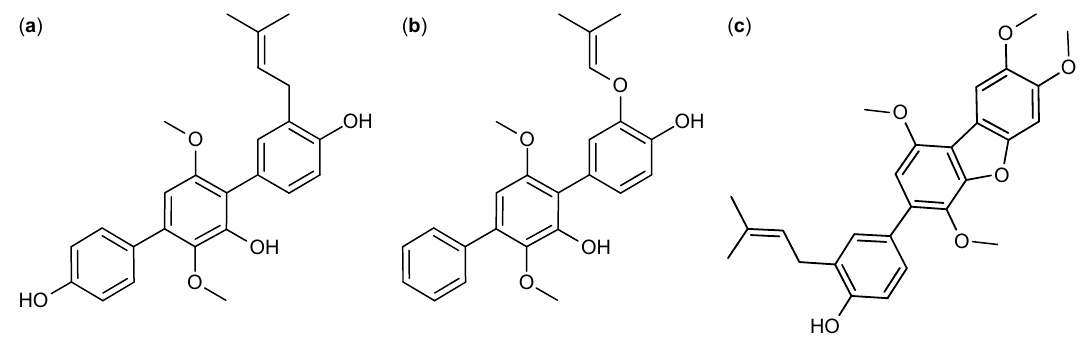
Figure 8. Prenylterphenyllins: ( a ) Prenylterphenyllin A, ( b ) 4 ′′ -Deoxyisoterprenin, and ( c ) Prenylcandidusin B.